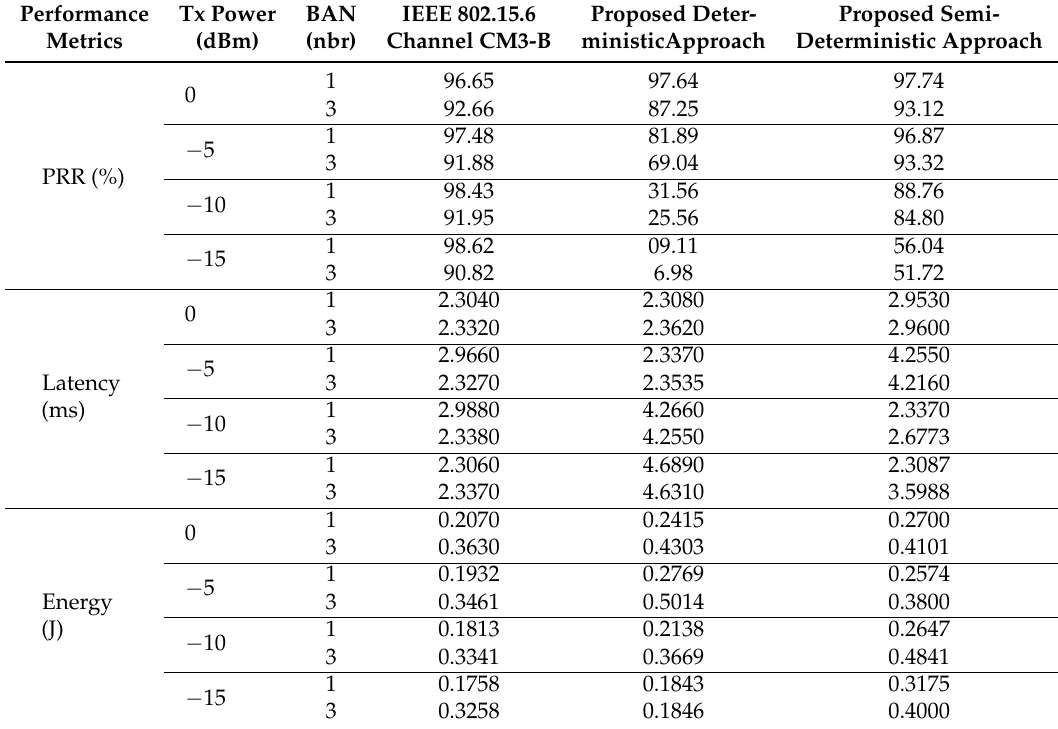
Table 10. PRR, energy consumption and latency under varying Tx power and BANs for different channel and mobility models. It can be noticed that the granularity of the variations in delay and energy consumption is 10 − 6 ( i.e. , µ s ) and 10 − 3 ( i.e. , mJ) respectively. Performance Tx Power BAN IEEE 802.15.6 Proposed Deter- Proposed Semi-